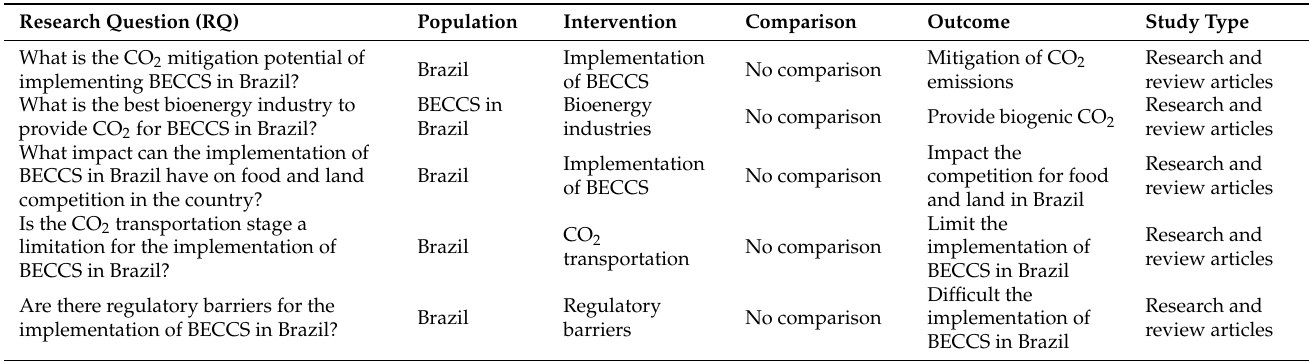
Table 1. Research questions for this article’s systematic literature review.